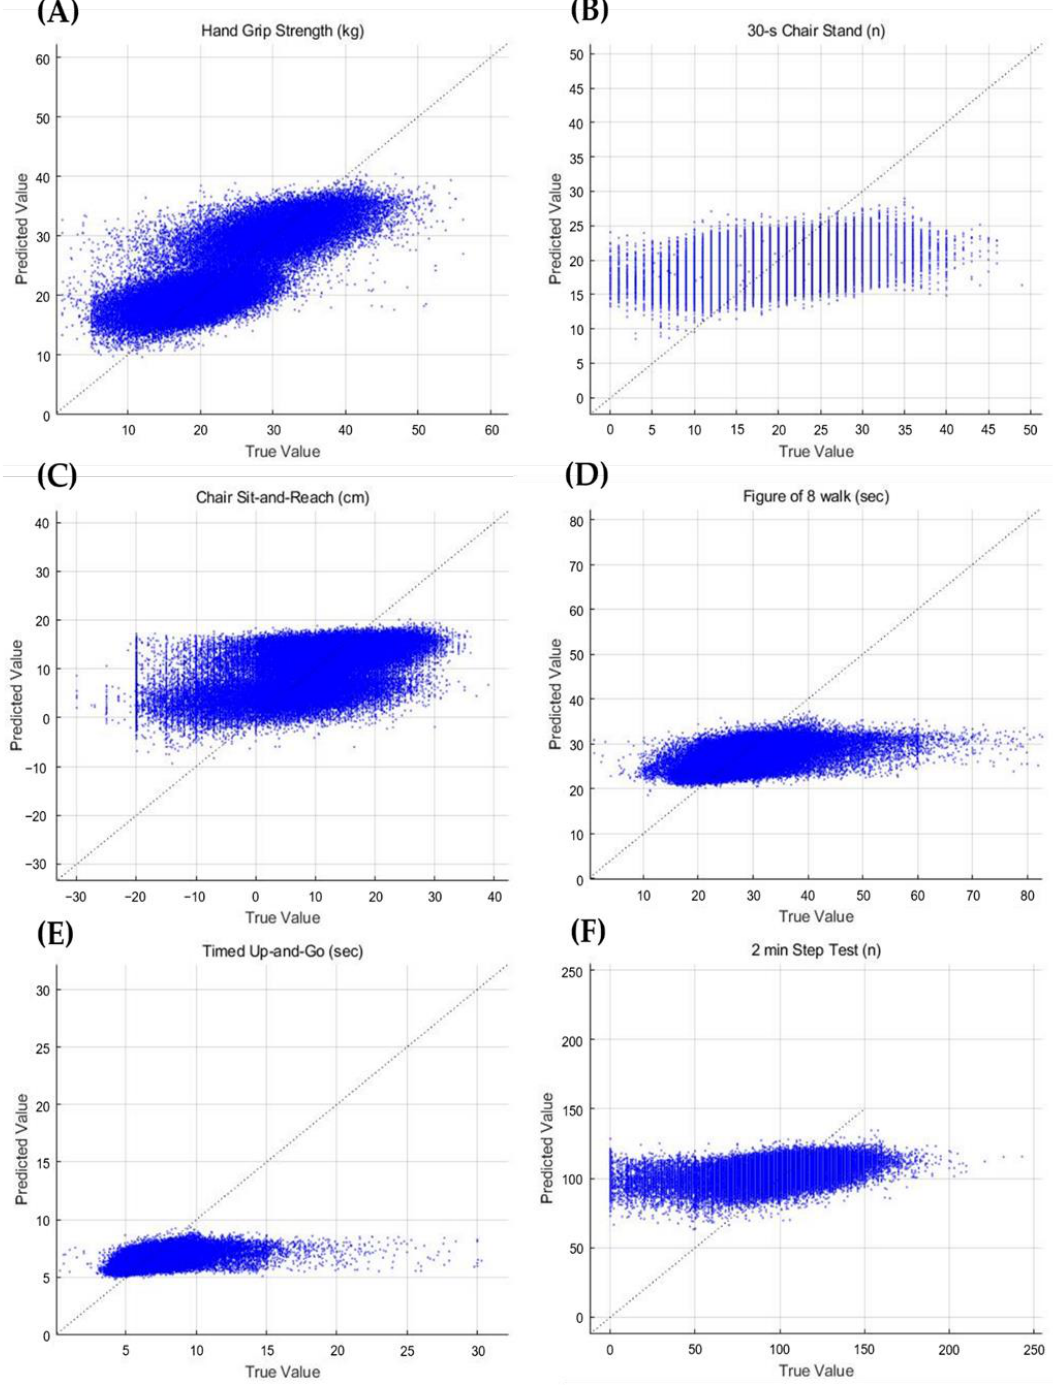
Figure 2. Relationship between the measured and predicted FF variables using scatter plots. ( A ) HGS, ( B ) 30 s chair stand test, ( C ) chair sit-and-reach test, ( D ) figure-of-eight walk test, ( E ) timed up-and-go test, and ( F ) 2 min step test results.